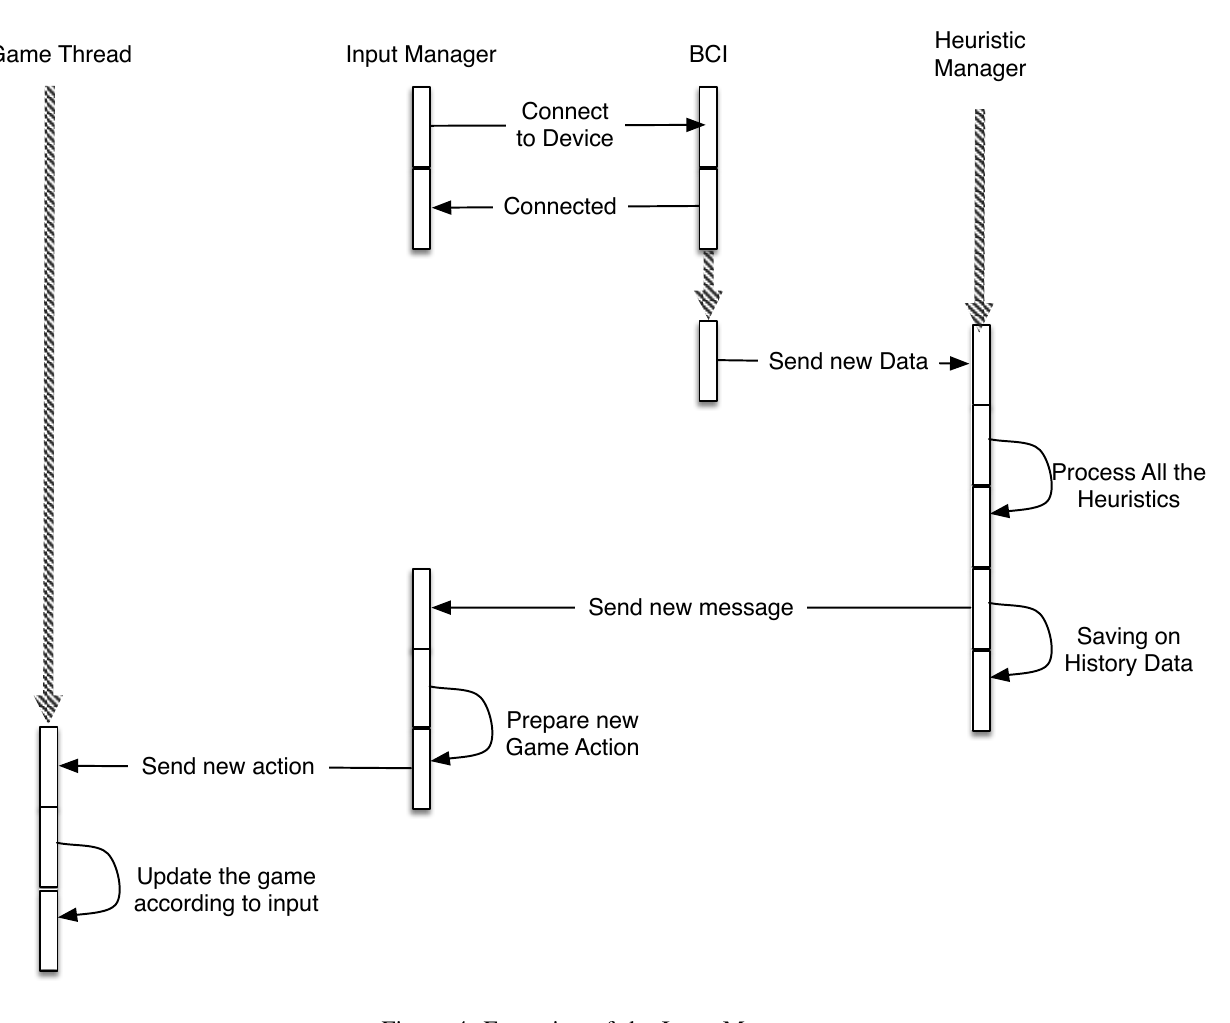
Figure 4: Execution of the Input